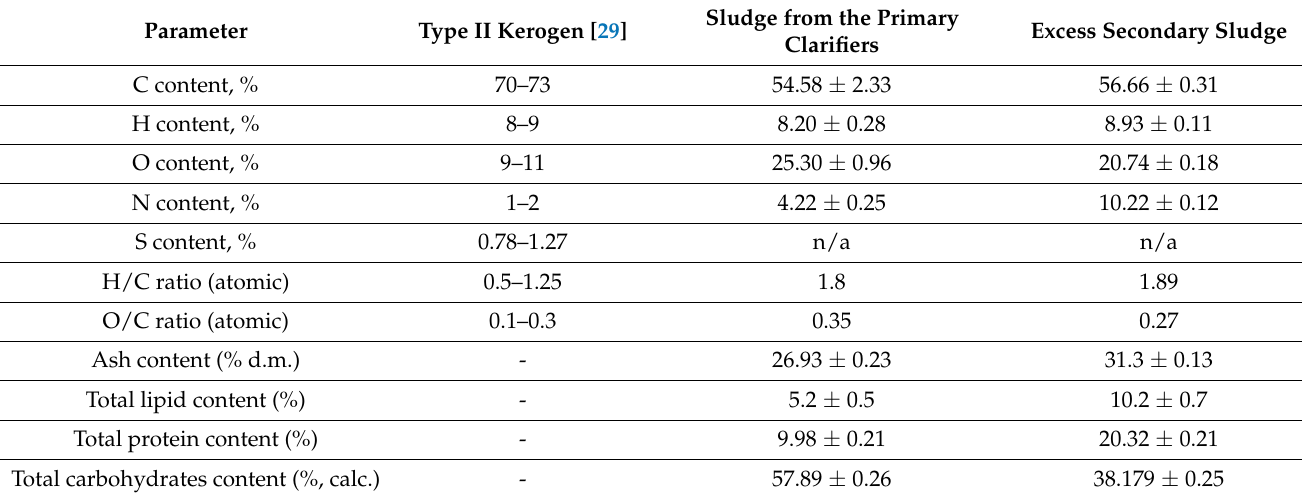
Table 2. Comparison of kerogen and sewage sludge composition.